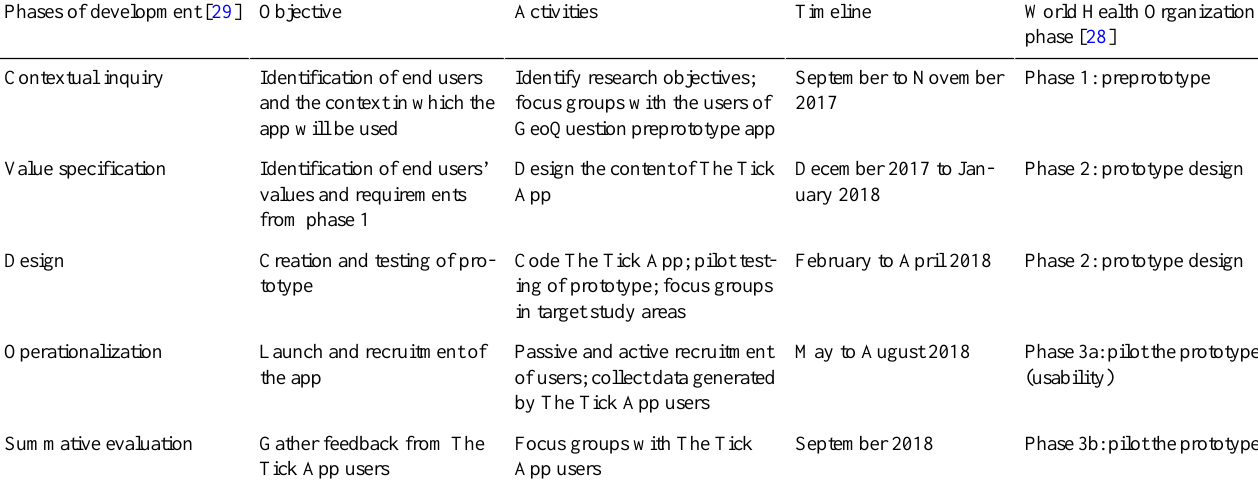
Table 1. Phases, objectives, activities, and timeline in the design process of The Tick App based on the roadmap proposed in a study by van Velsen et al for creating mobile health apps and the guidelines for monitoring and evaluating mobile health interventions developed by the World Health